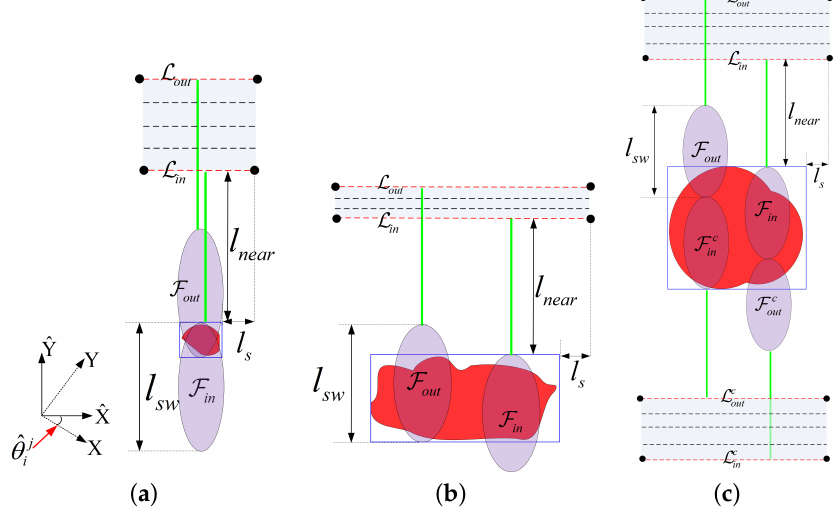
Figure 9. Collection segments of different ROIs. ( a ) point ROI; ( b ) quasi-point ROI; ( c ) distributed